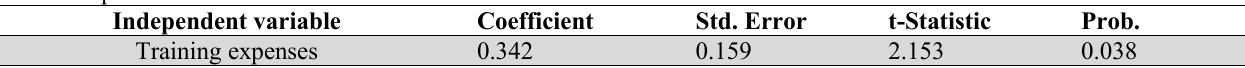
The effect of the second independent variable: Total training expenditures for workers in Jordanian banks on the dependent variable net profit after tax Independent variable